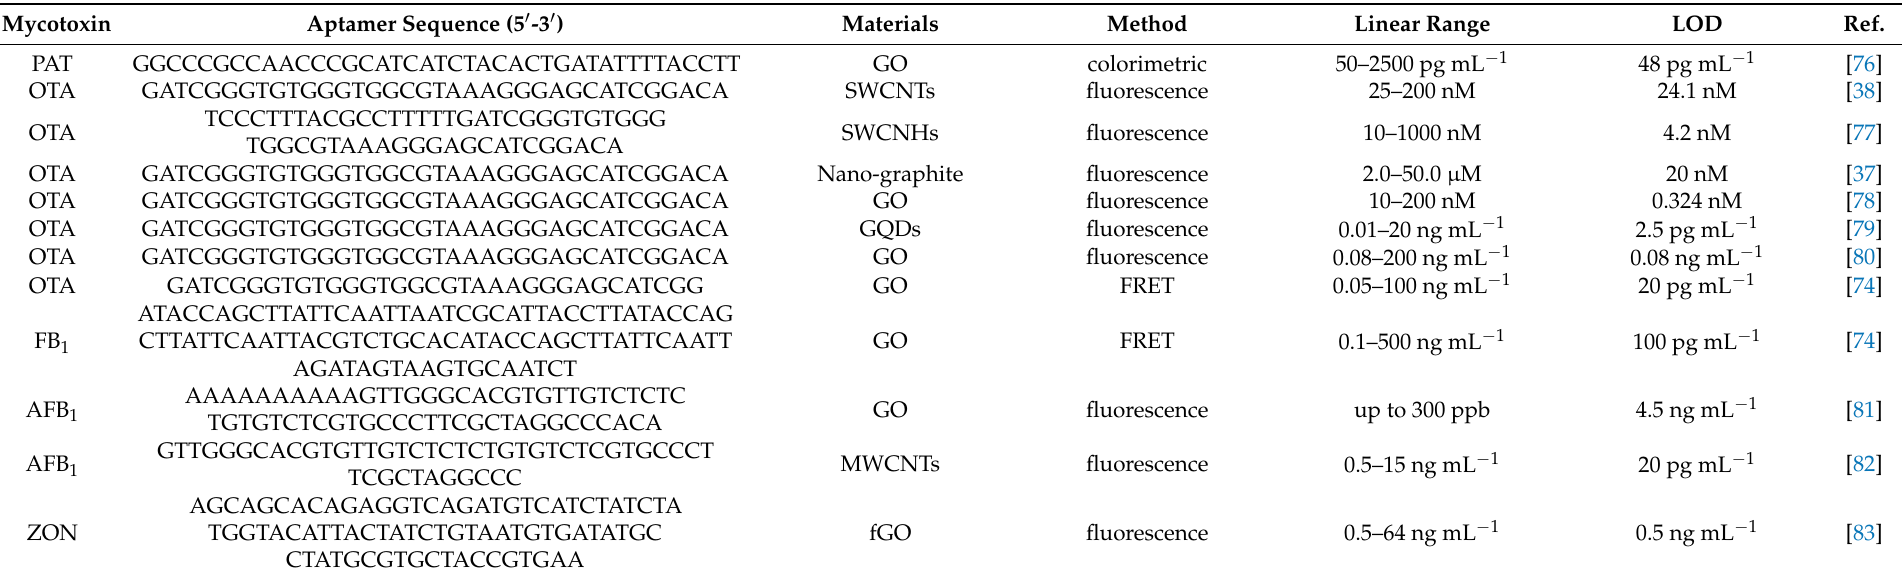
Table 2. Nanocomposite-based aptasensors for